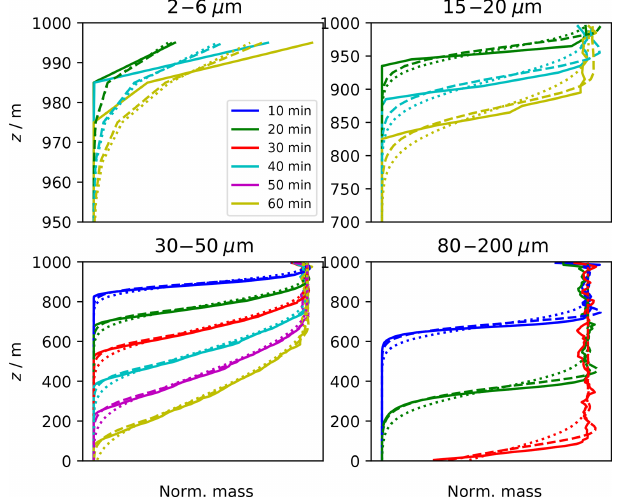
Figure A2. Pure sedimentation test case: comparison of BIN and LCM advection. EmptyDom set-up with an exponential distribution with r init = 50µm as influx condition. Displayed are vertical pro- files of normalised mass within specified size ranges (see the head- ing of each panel) at the indicated points in time. Note that most panels use different y -axis ranges and do not show all six points in